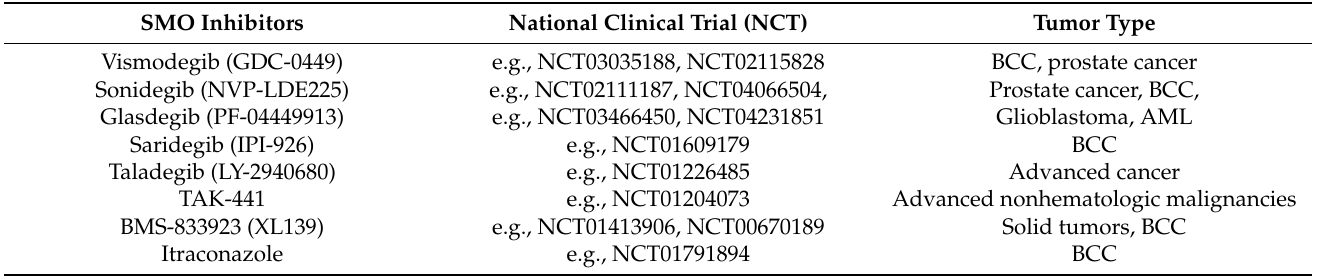
Table 1. SMO inhibitors used in clinical